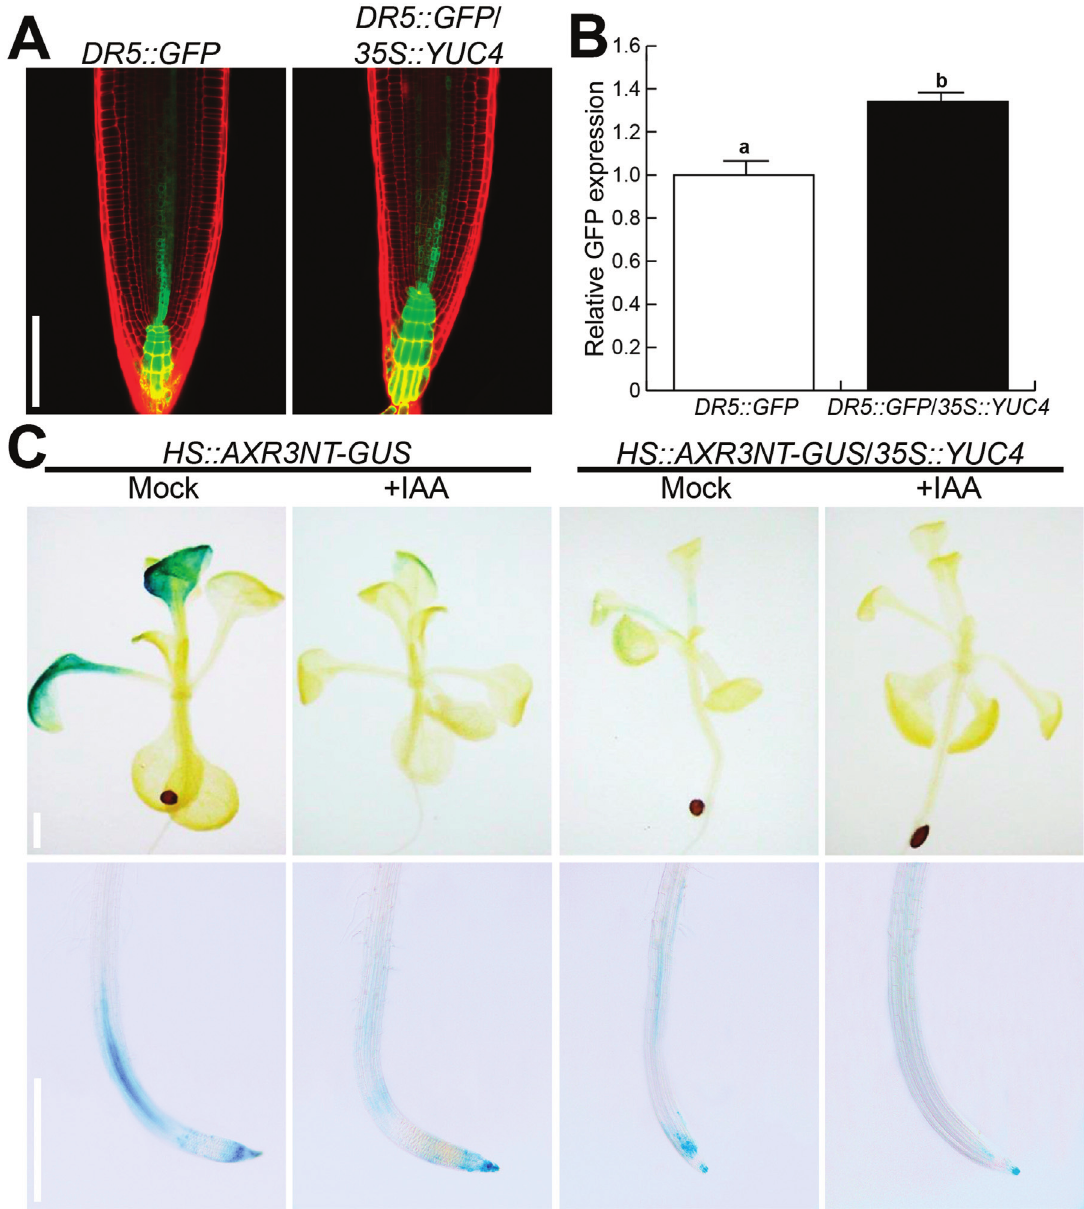
Figure 2 - The Arabidopsis thaliana 35S::YUC4 seedlings show an increased auxin response. (A) DR5::GFP in root tips of WT and DR5::GFP / 35S::YUC4 seedlings, (B) Relative quantification of GFP fluorescence (n = 10 (cid:5) standard error), different letters indicate statistical differ- ences at P < 0.05 . (C) HS::AXR3NT-GUS expression in shoots and roots of WT and YUC4 overexpressing seedlings. Seedlings were germinated and grown10don0.2XMSmedium,transferredto0.2XMSliquidmediumandheatshockedfor2hat37°Ctoinduceexpressionofthetransgene.Seedlings then were transferred to 20 °C medium containing mock and 2 (cid:2) M IAA and incubated for 1 hr before staining for (cid:3) -glucuronidase activity. Photographs show representative individuals from at least 10 stained seedlings. Scale bar in A 100 (cid:2) m; scale bars in C 500 (cid:2) m. The experiment was repeated